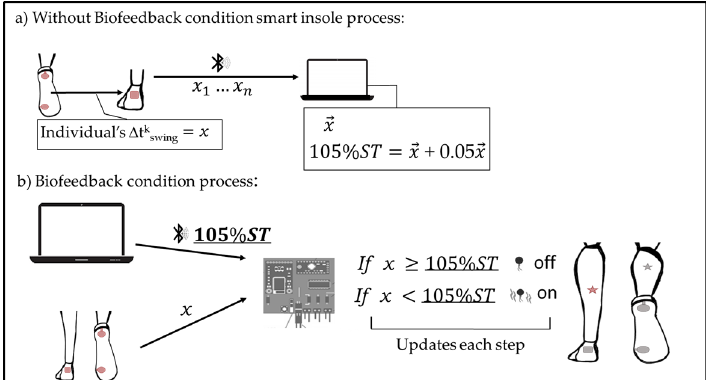
Figure 2. Diagram of smart insole process. Individual’s swing time ( x ) was collected from the smart insole ( a ), which would be used as a reference to increase each individual’s swing time by 5% during Biofeedback condition ( b ).